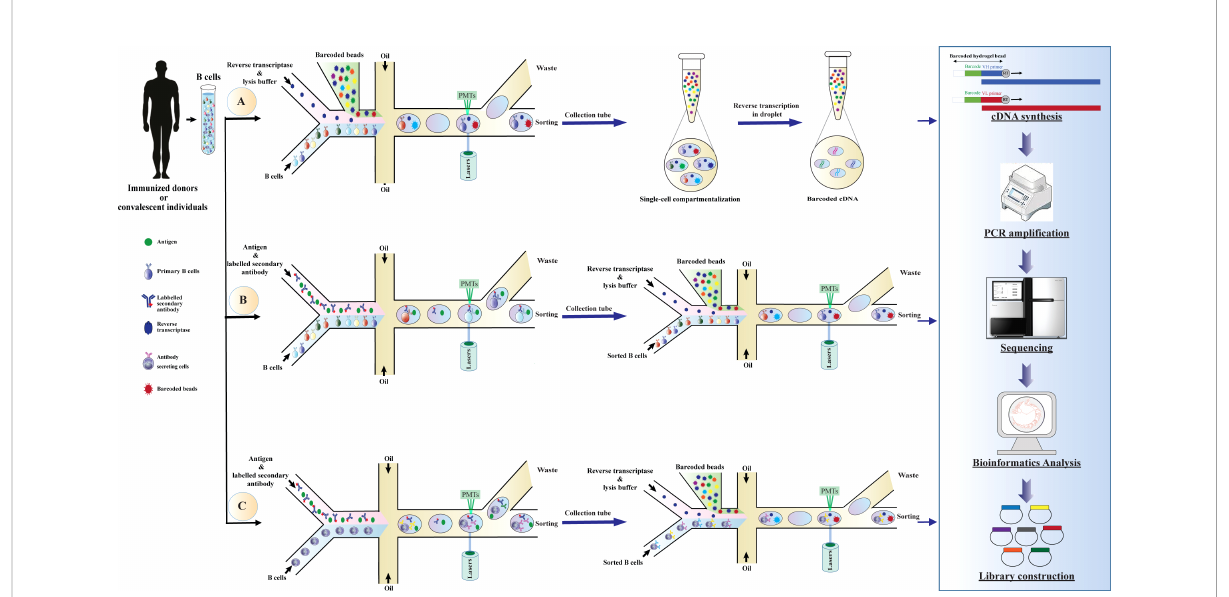
FIGURE 3 Schematic overview of application droplet-based micro fl uidics for high-throughput screening of human B cells repertoire and library construction. Development of antibody libraries is based on screening (A) human B cells repertoire, (B) B cells binding to a speci fi c antigen, or (C) B cells secreting antibodies binding to a speci fi c antigen. The basic steps of the method are as follows: droplets with a speci fi c fl uorescence intensity are de fl ected into the collection channel through electric fi elds. The selected cells are re-compartmentalized in the droplets simultaneously with a hydrogel bead coupled with uniquely barcoded polyT primers to generate droplets containing a single cell and a single bead. After cell lysis, reverse transcription is conducted for the V H and V L domains in the droplets. Since the cDNAs synthesized from each cell are conjugated with a unique barcode (corresponding to mRNAs produced in the droplets), cognate V H and V L pairs can be identi fi ed by NGS and subsequently used for library generation. cDNA, complementary DNA; mRNA, messenger RNA; V H , variable domain of the heavy chain; V L , variable domain of the light chain, NGS, next-generation sequencing; PMTs, photomultiplier